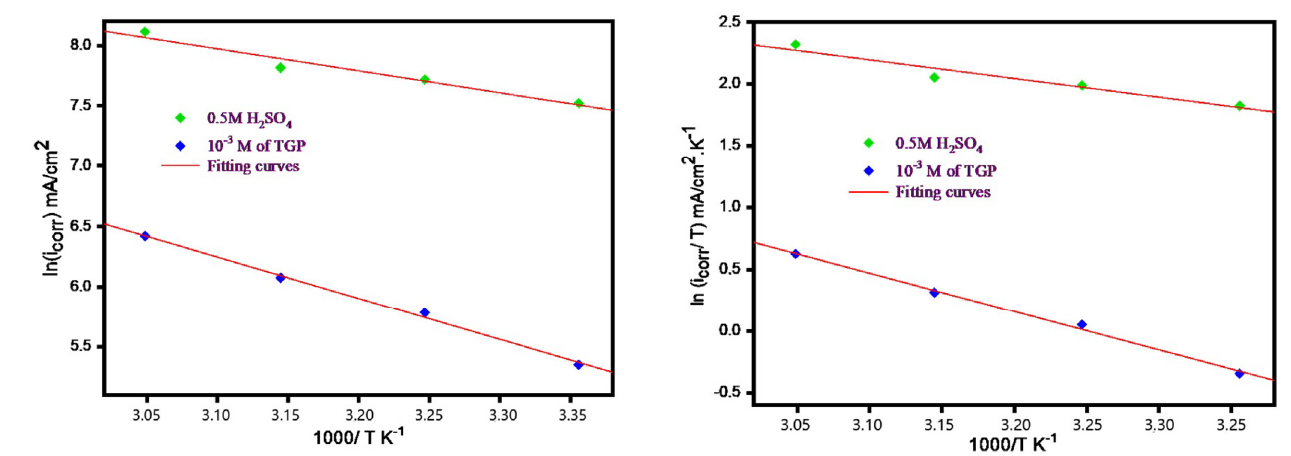
Figure 6. Ln( i corr ) as a function of 1000/T ( left ) and Ln( i corr / T ) as a function of 1000/T ( right ) curves for MS uninhibited and inhibited in 0.5 M H 2 SO 4 with 10 − 3 M of TGP.